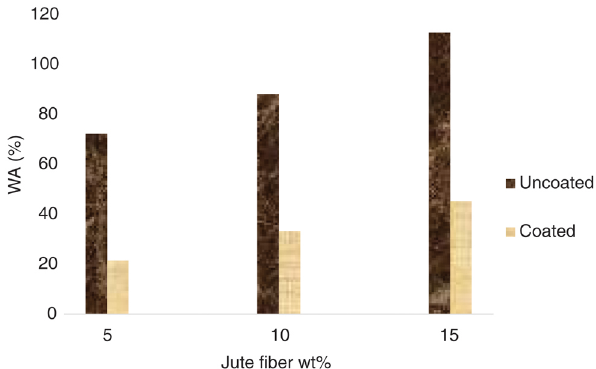
Figure 15: Maximum WA for uncoated and coated